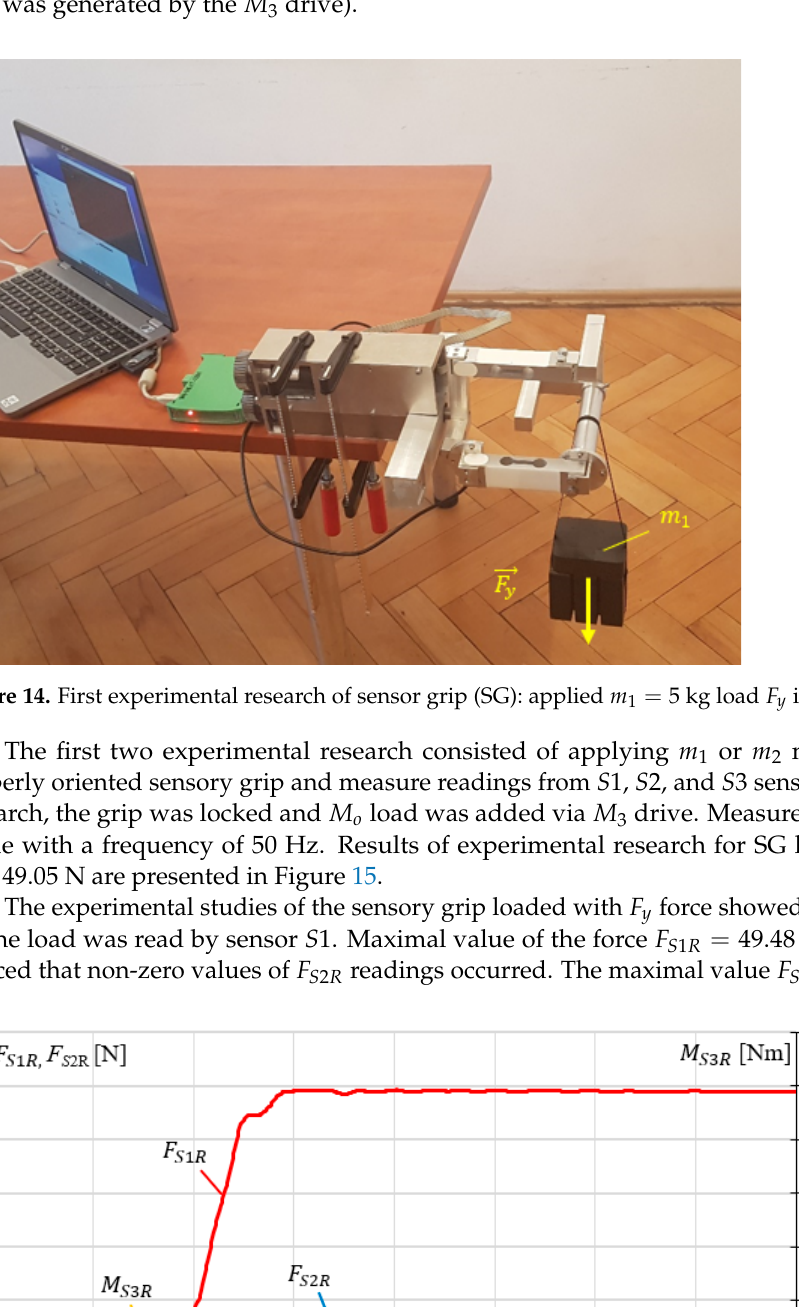
Figure 16. Experimental research results for the grip loaded with 7 kg mass in x direction. The last research concerning SG consisted on locking the grip in place and generating 𝑀 (cid:2871) = 7 Nm torque, which is considered as 𝑀 (cid:3042) in this research. The experiment consisted in examining the influence of 𝑀 (cid:3042) on 𝐹 (cid:3020)(cid:2869)(cid:3019) and 𝐹 (cid:3020)(cid:2870)(cid:3019) readings. The measurement results are shown in Figure 17. Figure 17. Experimental research results for the grip loaded with 7 Nm torque.